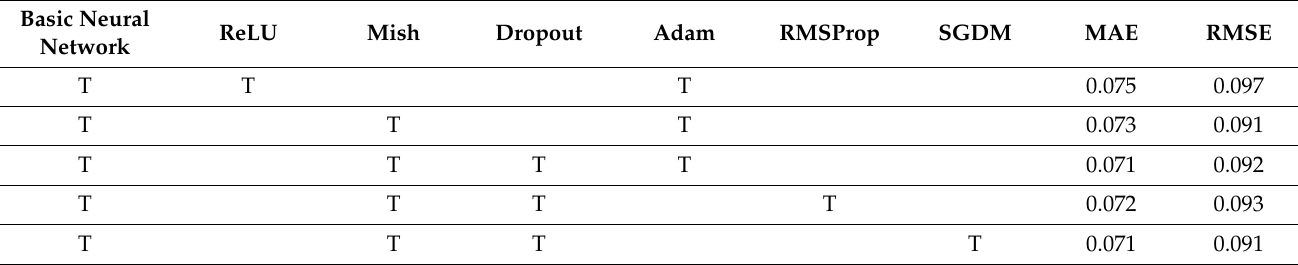
Table 5. The outputs of the neural network.